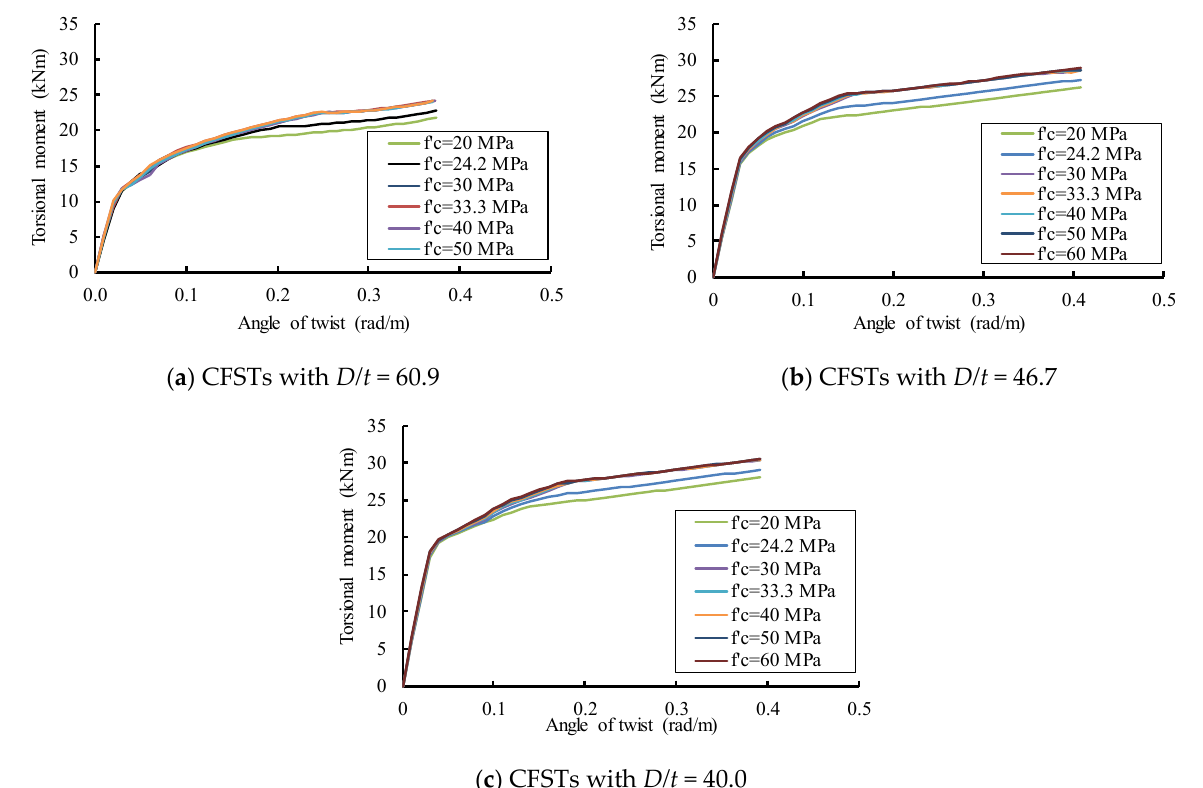
Figure 11. Effect of concrete strength on the torsional behavior of CFSTs with different D/t ratios.